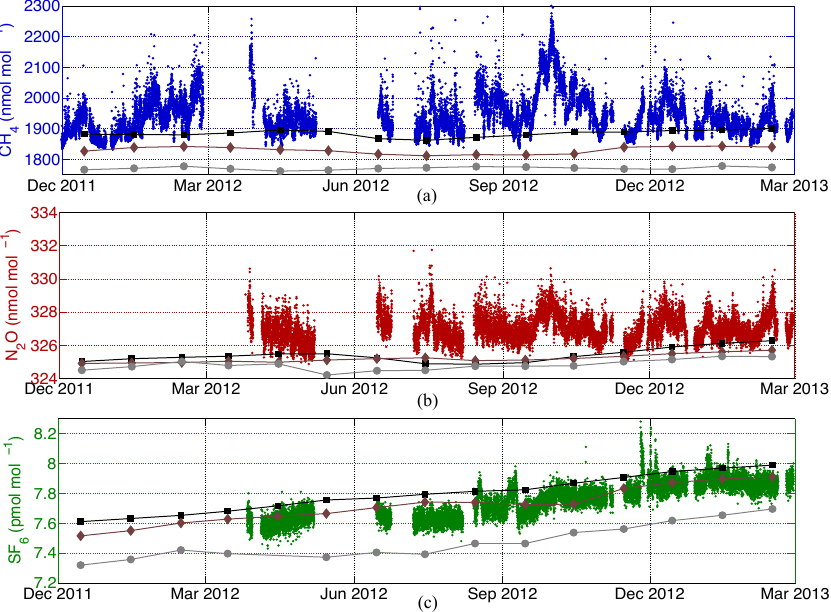
Fig. 4. Measurements of (a) CH 4 (blue) (b) N 2 O (red) and (c) SF 6 (green) mole fractions from Darjeeling, India. “Pollution-removed” monthly mean mole fractions from AGAGE measurements at Mace Head, Ireland (black squares), Ragged Point, Barbados (brown diamonds) and Cape Matatula, American Samoa (grey circles) are shown for comparison.